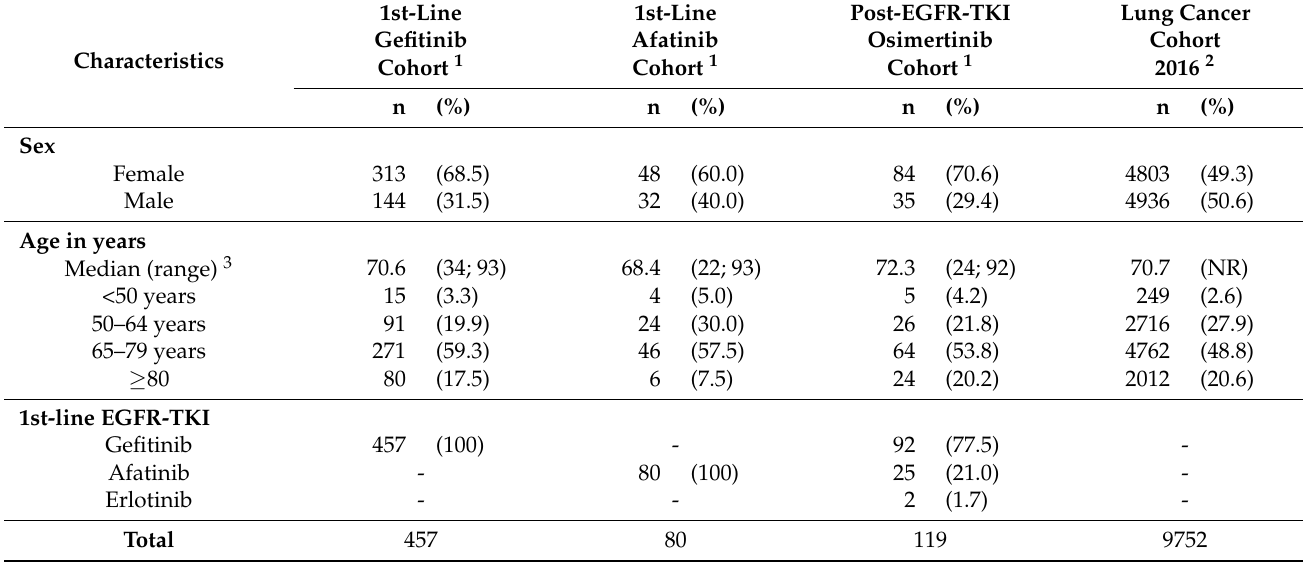
Table 2. Characteristics of patients in EGR-TKI cohorts.